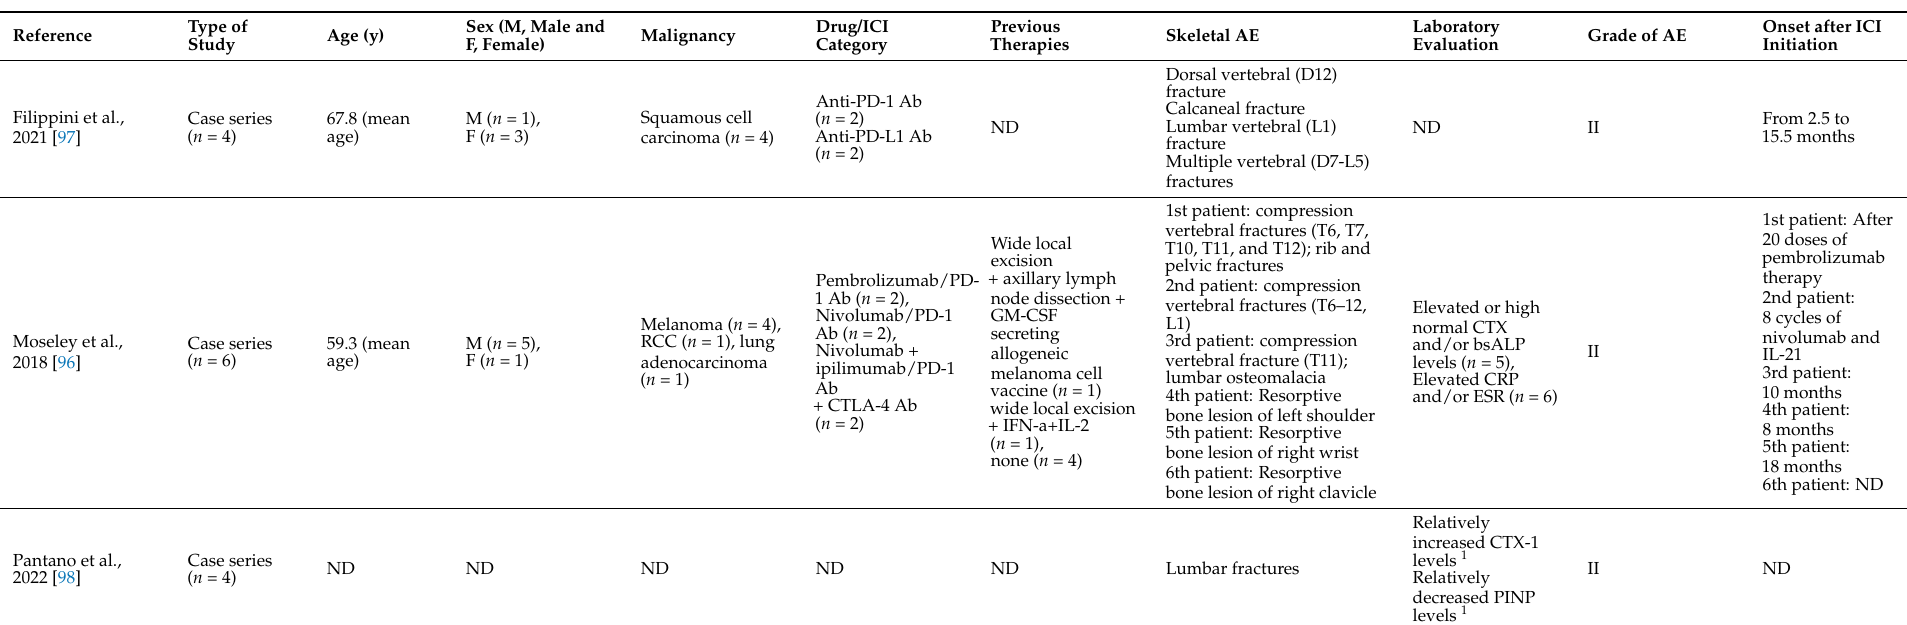
Table 5. Cases in the literature presenting ICI-related skeletal